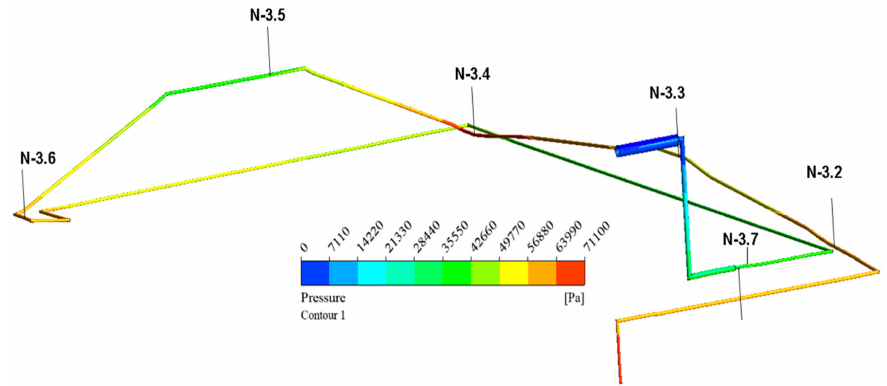
Figure 6. Pressure distribution obtained during calibration of the CFD model of the entire 100 m long laboratory installation.